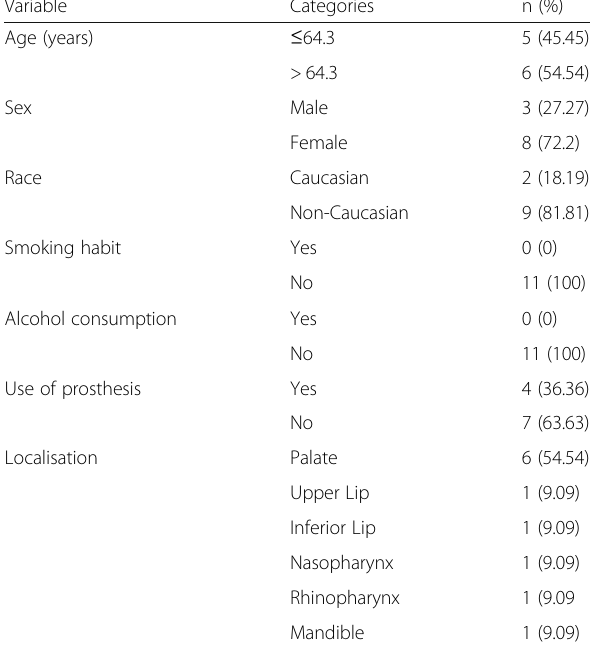
Table 1 Distribution of the 11 ACC cases according to demographic, lifestyle, and clinicopathological variables Variable